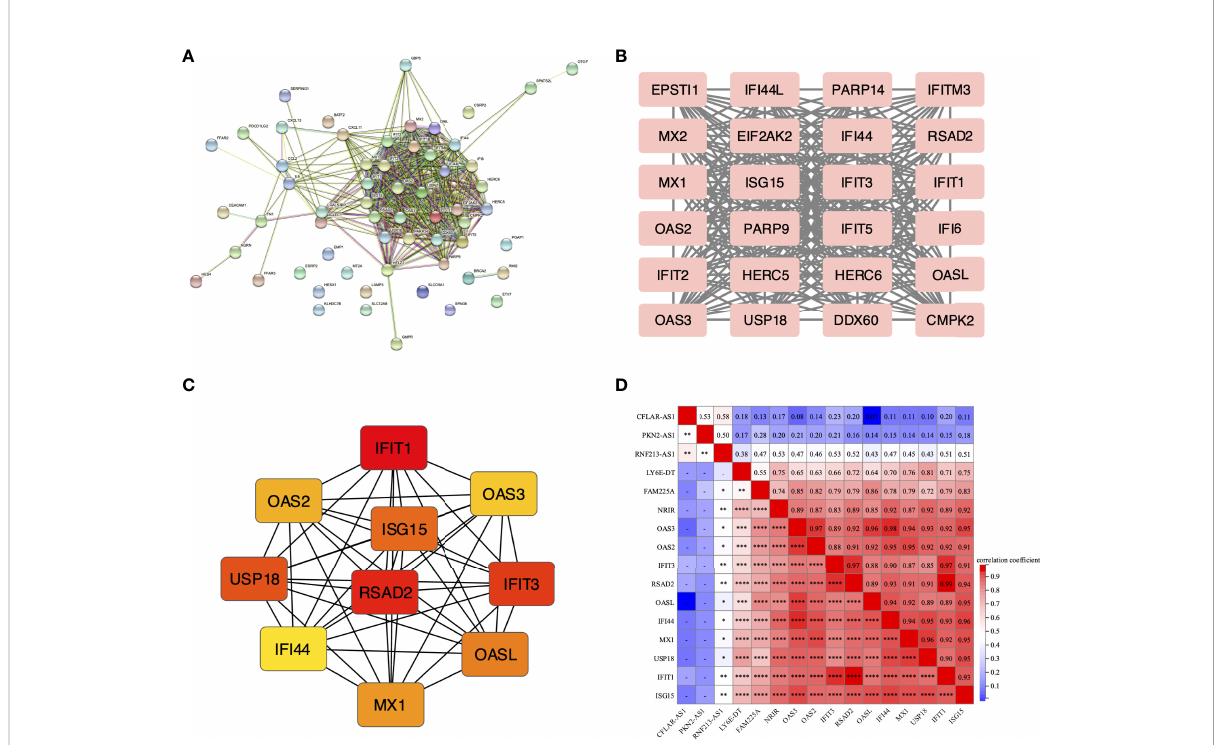
FIGURE 3 Interactions among the DEISGs. (A) The PPI network in DEISGs. (B) The most signi fi cant module in the PPI network. (C) Top 10 hub ISGs based on maximal clique centrality (MCC). (D) The correlation heatmap of the 6 lncRNAs and 10 hub ISGs. * P < 0.05, ** P < 0.01, *** P < 0.001, **** P < 0.0001, - P ≥